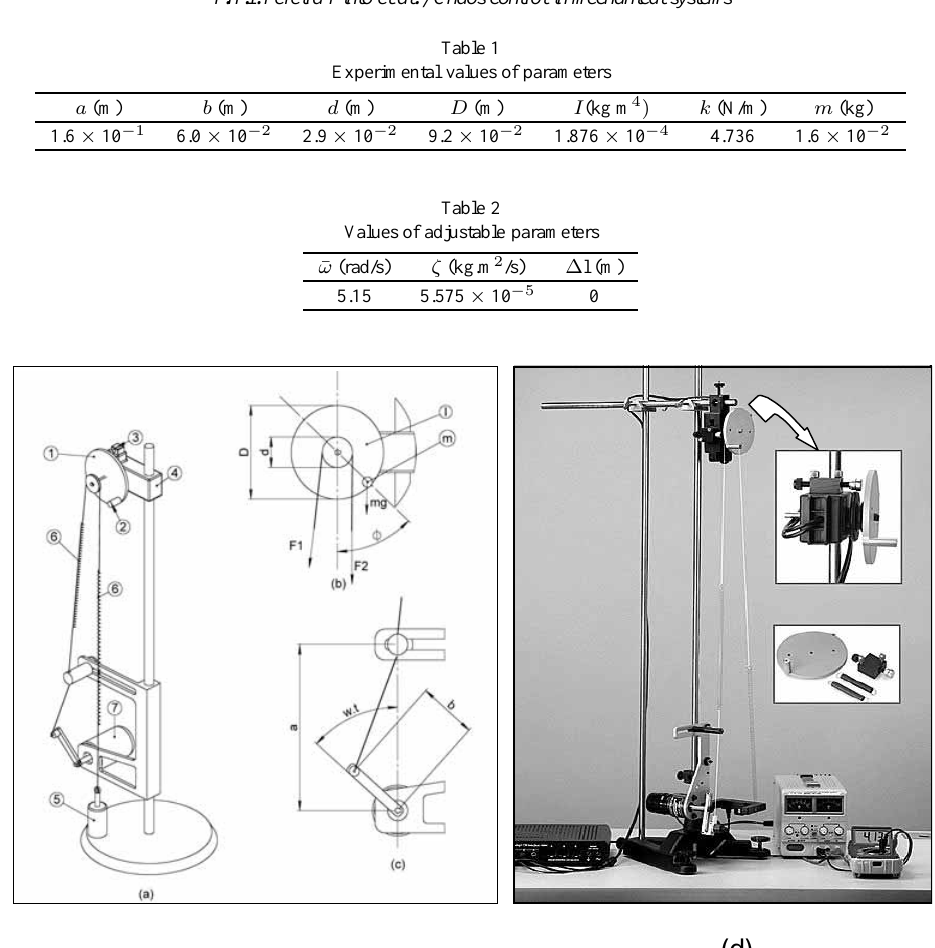
Fig. 1. Nonlinear pendulum. (a) Physical Model. (1) Metallic disc; (2) Lumped mass; (3) Magnetic damping device; (4) Rotary Motion Sensor; (5) Actuator; (6) String-spring device; (7) Electric motor. (b) Parameters and forces on the metallic disc. (c) Parameters from driving device. (d) Experimental